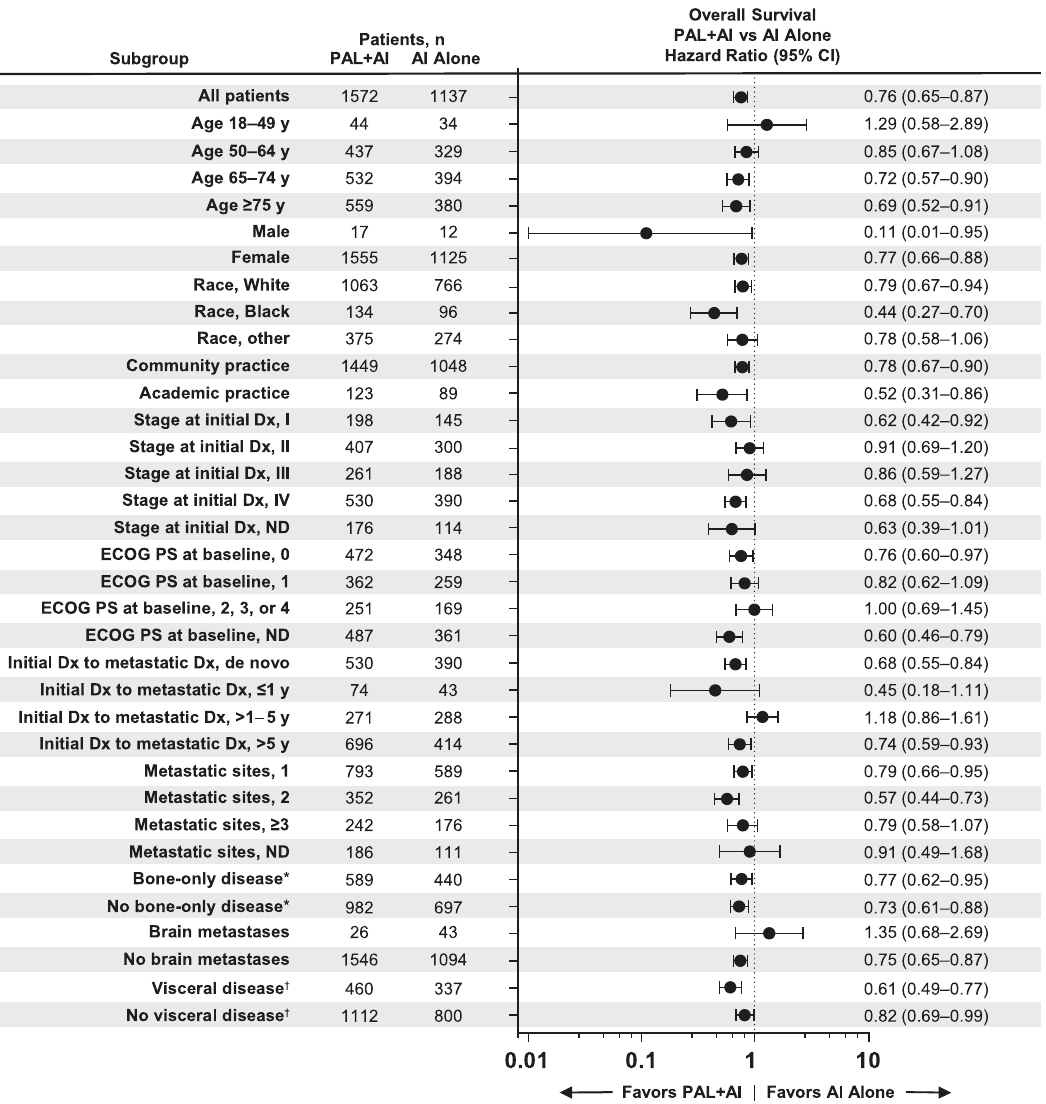
Fig. 3 Forest plot of overall survival by subgroup after sIPTW. AI aromatase inhibitor; Dx diagnosis; ECOG PS Eastern Cooperative Oncology Group performance status; ND not documented; PAL palbociclib; sIPTW stabilized inverse probability of treatment weighting. * Bone-only disease was de fi ned as metastatic disease in the bone only. † Visceral disease was de fi ned as metastatic disease in the lung and/or liver; patients could have had other sites of metastases. No visceral disease was de fi ned as no lung or liver